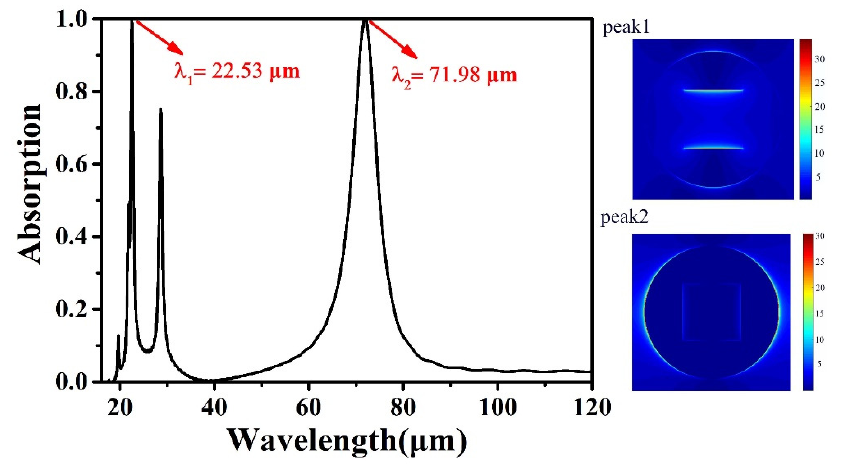
Figure 3. The optical absorption spectrum of the “ancient coin” structure and the corresponding electric field diagrams of the two perfect absorption peaks on the x-y plane.